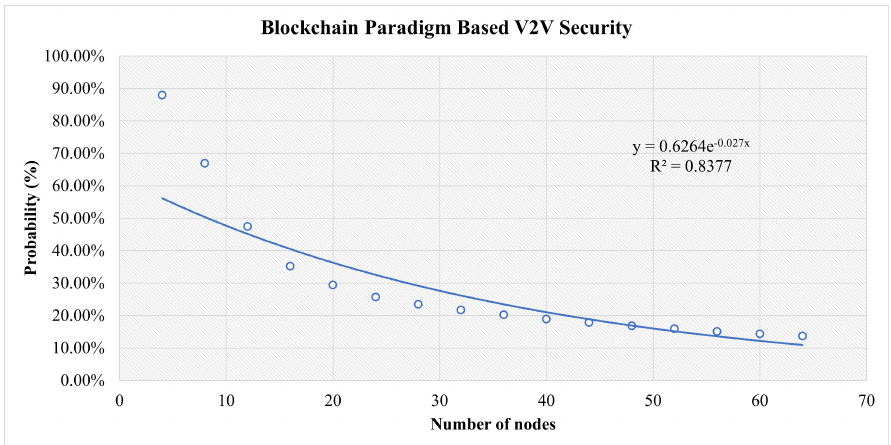
Figure 11. Results for Three Categories of Attacks in the Blockchain-Based